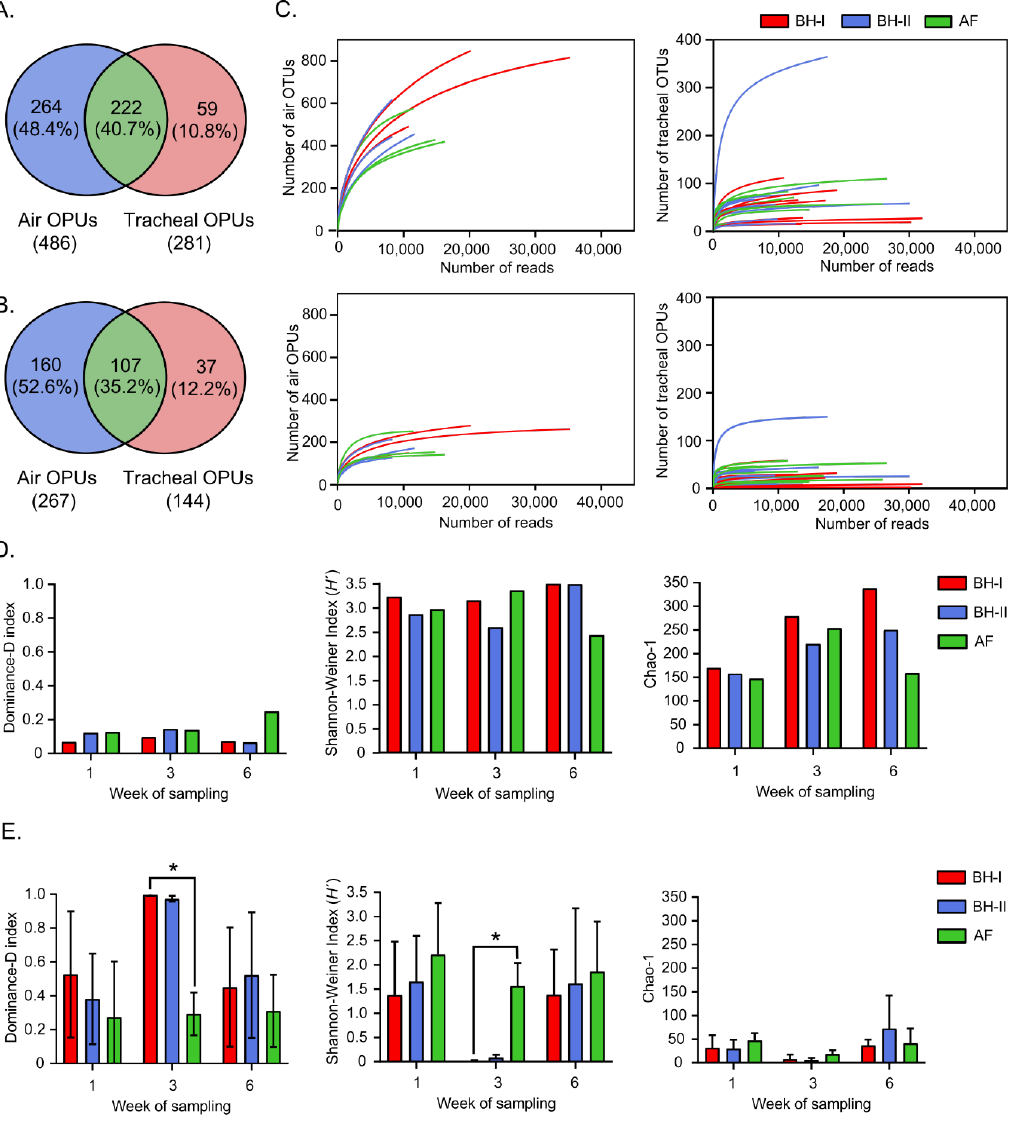
Figure 3. OPU distribution, rarefaction, and alpha diversity. Venn diagram before ( A ) and after ( B ) discarding OPUs for air and tracheal samples harboring <10 sequences and occurring in a single sample. ( C ) Rarefaction curves for detected OTUs and OPUs, where each line represents an inde- pendent sample. Alpha diversity indices for air samples ( n = 1) ( D ) and tracheal samples ( n = 3) ( E ), where the average of the tracheal diversity index ± standard deviation for each group is plotted.